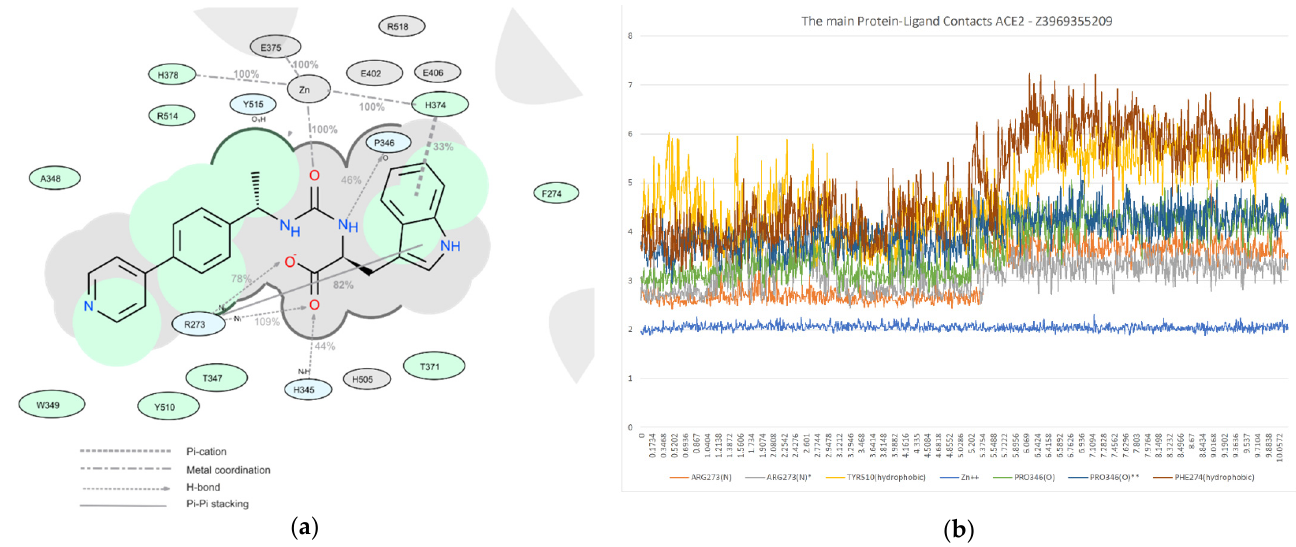
Figure 12. A detailed interaction scheme of ligand atoms (Z3969355209) with protein residues: ( a ) generalized graphical representation of the interactions and contacts (H-bonds, hydrophobic, ionic, water bridges); ( b ) scheme showing the distance evolution (in Å) between the ligand and residues.